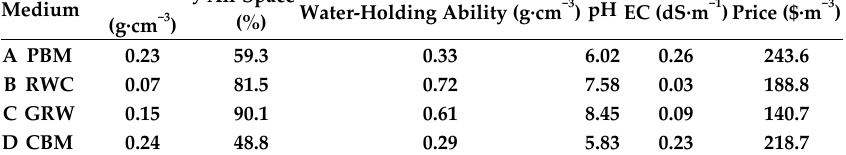
Figure 2. Physical morphology, physicochemical property, and cost of the four common propagation media in South Korea. ( A ) A peat moss-based mixture (PBM); ( B ) rockwool cube (RWC); ( C ) granular rockwool (GRW); ( D ) a coir-based mixture (CBM).